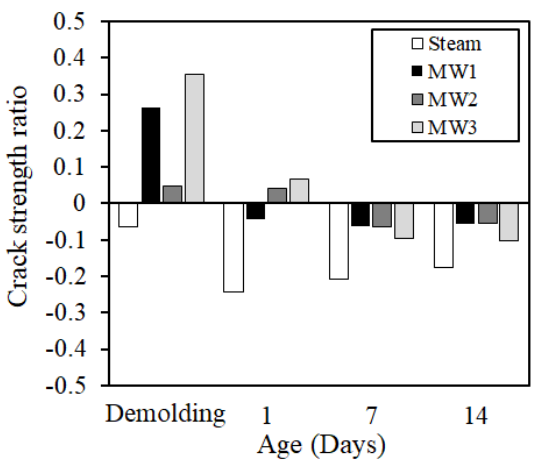
Figure 19. Restraint stress.